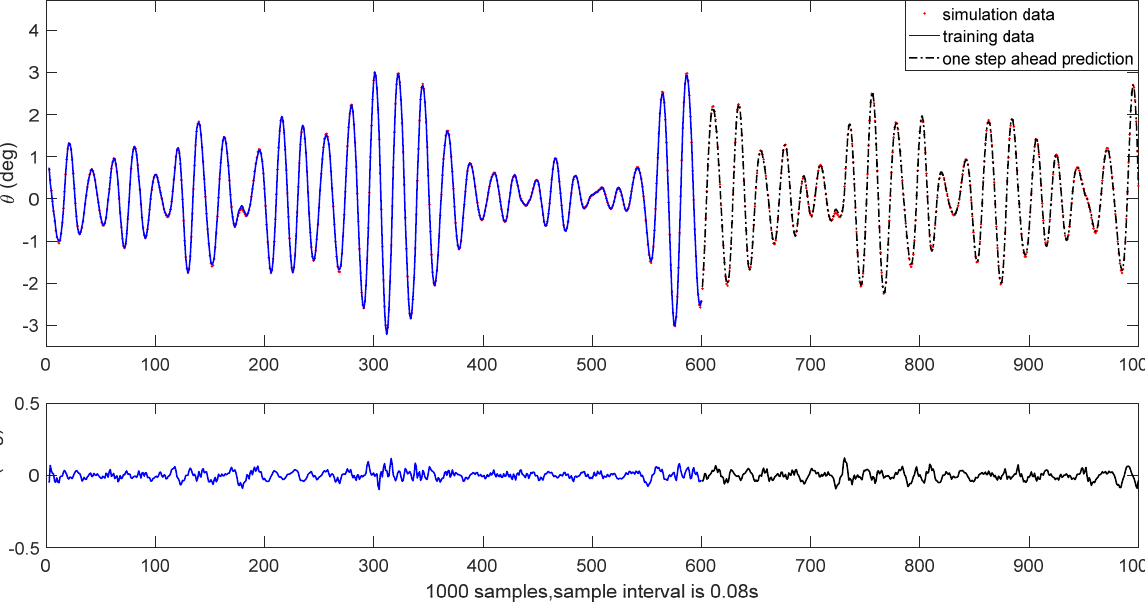
Figure 15. The one-step ahead prediction of pitch motion in irregular waves for the FPSO model.